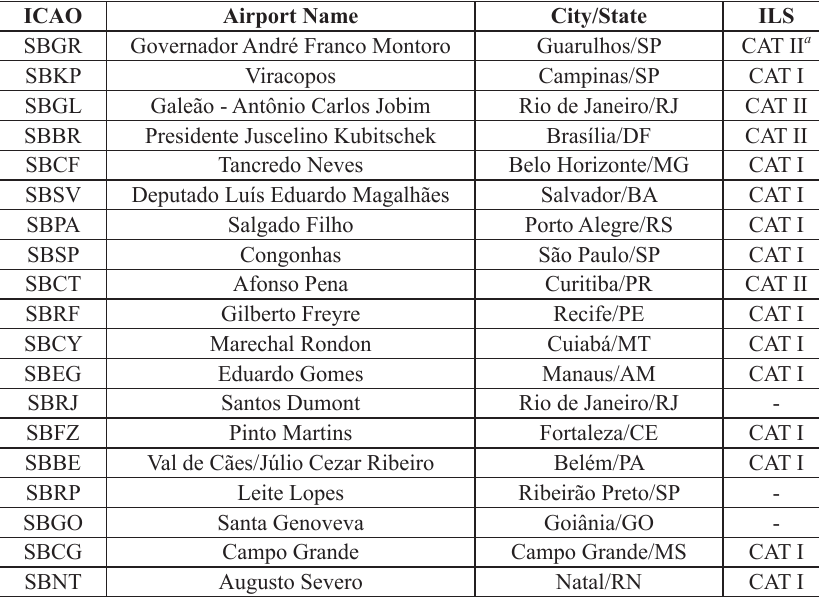
Main Brazilian Airports.